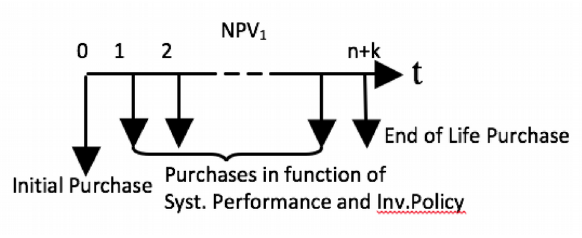
Figure 4. The effect of making or not an end-of-life purchase